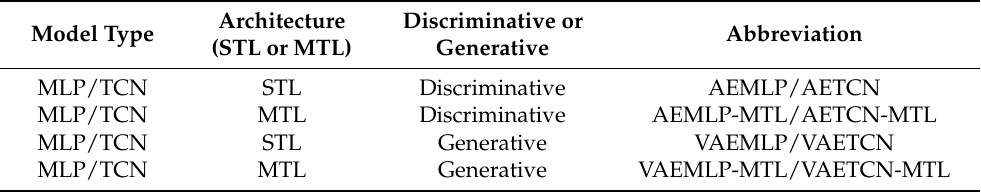
Table 2. Overview of autoencoder-based representation learning techniques. The model type is abbreviated as MLP for the multi-layer perceptron and TCN for temporal convolutional networks. MTL is an abbreviation for multi-task learning, where all parks of a datatype are trained in a unified autoencoder model. VAE is an abbreviation for a variational autoencoder as a generative approach for dimension